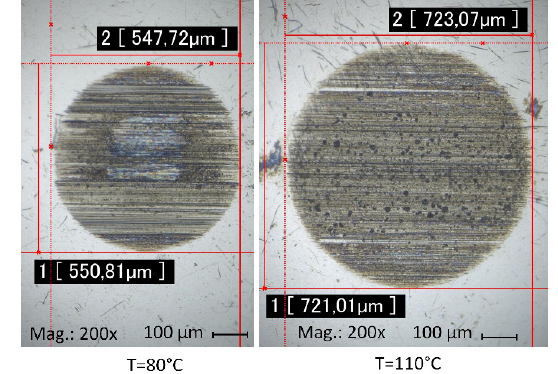
Figure 10. Wear scar images on the ball specimen surfaces with oil sample number 2 (50-hour running time) on 80 (left) and 110°C (right) (pictures of the